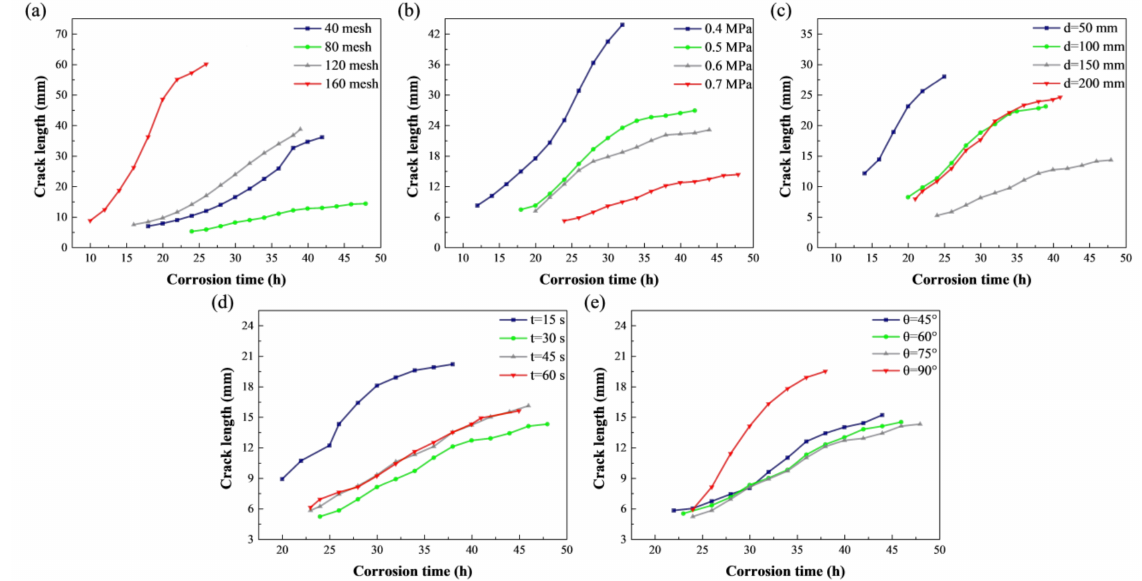
Figure 7. Variation of corrosion crack length under different grit blasting process parameters: ( a ) grit size; ( b ) blasting pressure; ( c ) blasting distance; ( d ) blasting time; ( e ) blasting